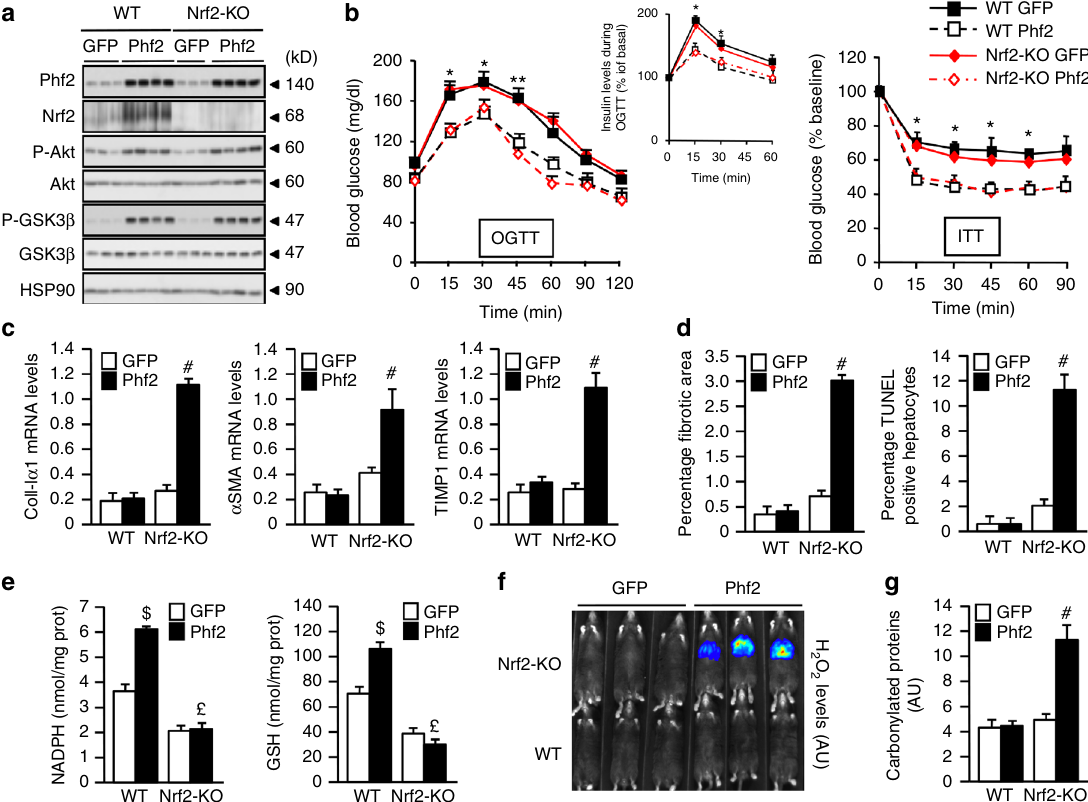
Fig. 6 Phf2-driven Nrf2 activation protects liver from fi brogenesis. GFP or Phf2 were overexpressed in the liver of Wild Type (WT) and Nrf2 knockout (Nrf2-KO) mice. Mice were studied 3 weeks later in the fed state. a Western blot analysis of liver extracts from WT or Nrf2-KO mice ( n = 10 mice per group). b (Left) Oral glucose tolerance test and insulin levels during the OGTT test. (right) Insulin tolerance test ( n = 10 per group). c Expression of coll-Ia1, α -SMA, and TIMP-1 ( n = 10 mice per group). d Percentage of fi brotic area and percentage of apoptotic hepatocytes ( n = 10 per group). e NADPH and